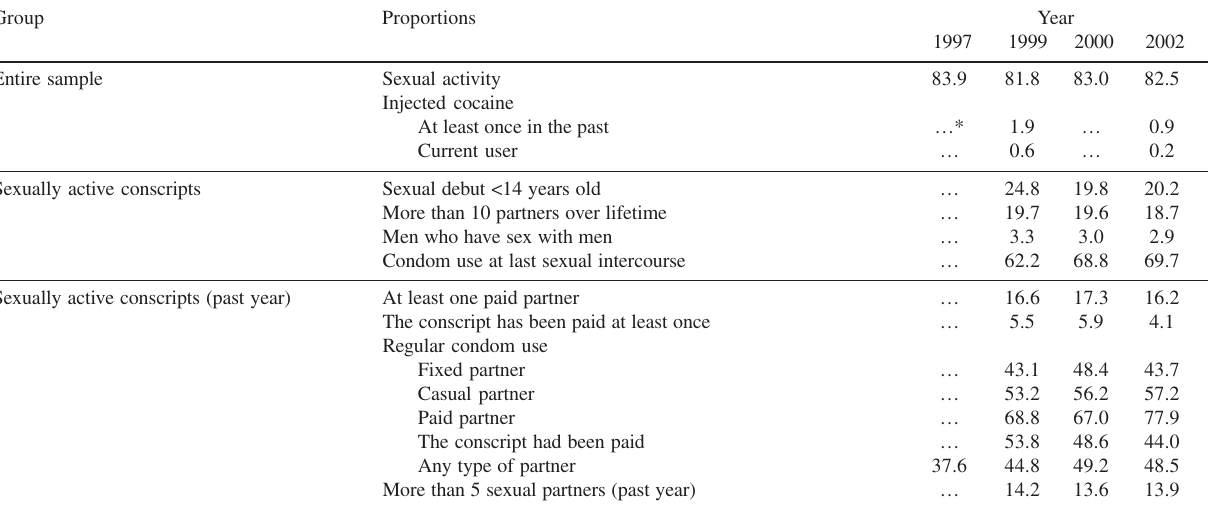
Table 2 – Indicators (%) of sexual behavior by year. Brazilian Army conscripts, 1997-2002 Group